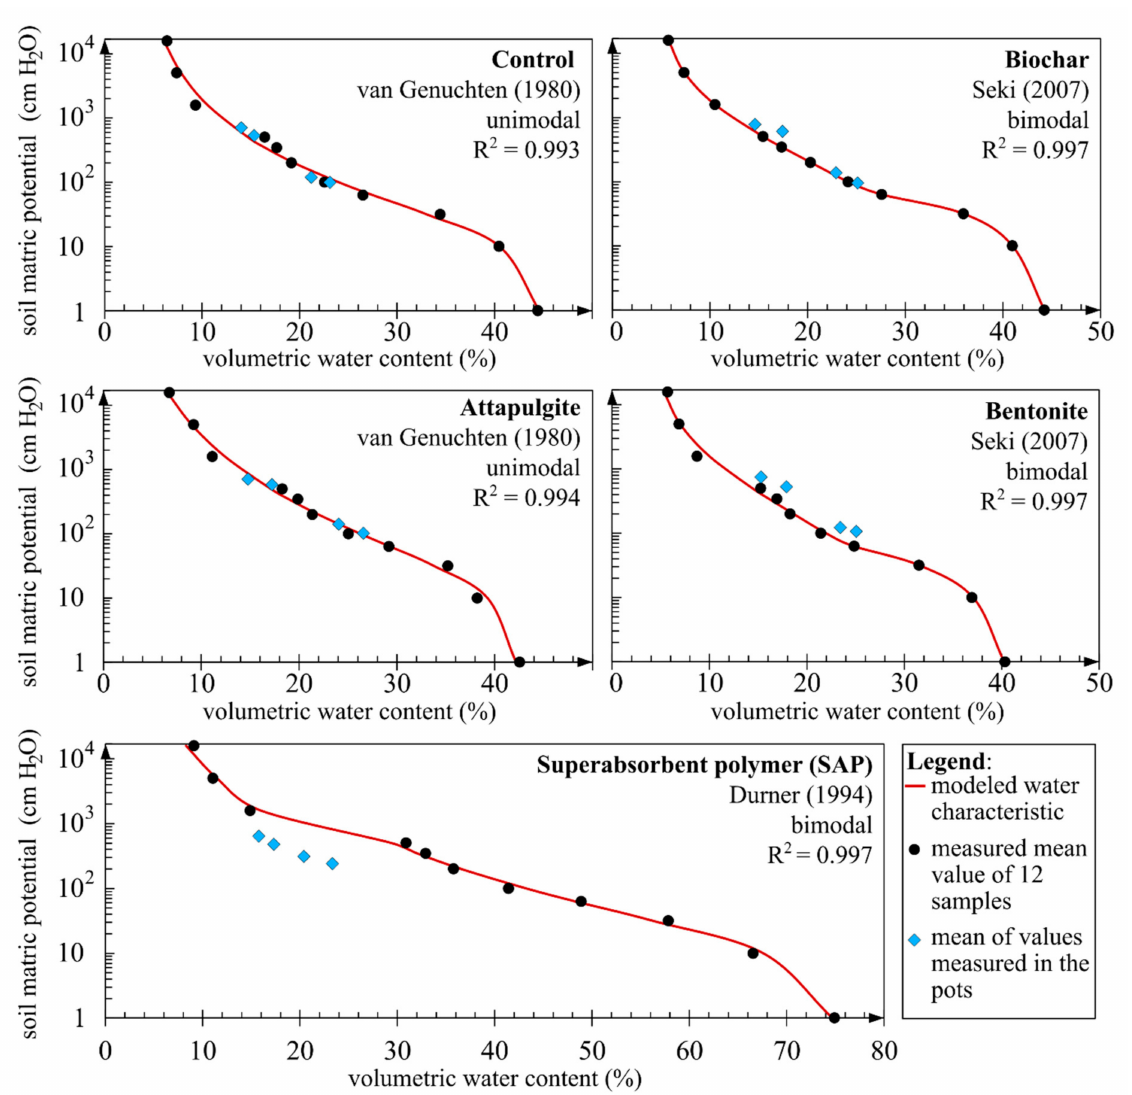
Figure 6. Water retention curves (drying curves) of soil samples (loamy sand) treated with soil amendments. Mean values of soil moisture for the samples from the pot experiment are imposed on the